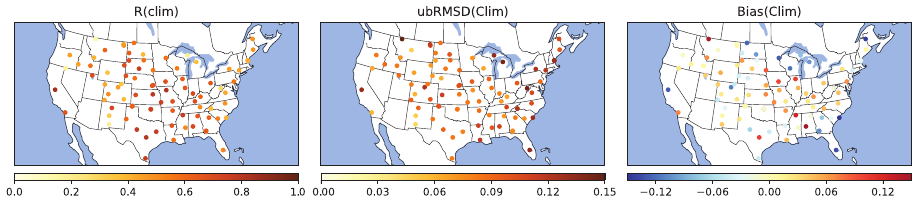
Figure 4. Pearson correlation coefficient (R), unbiased RMSD and bias between in situ soil moisture and soil moisture retrieved using vegetation parameters derived from climatological (clim)